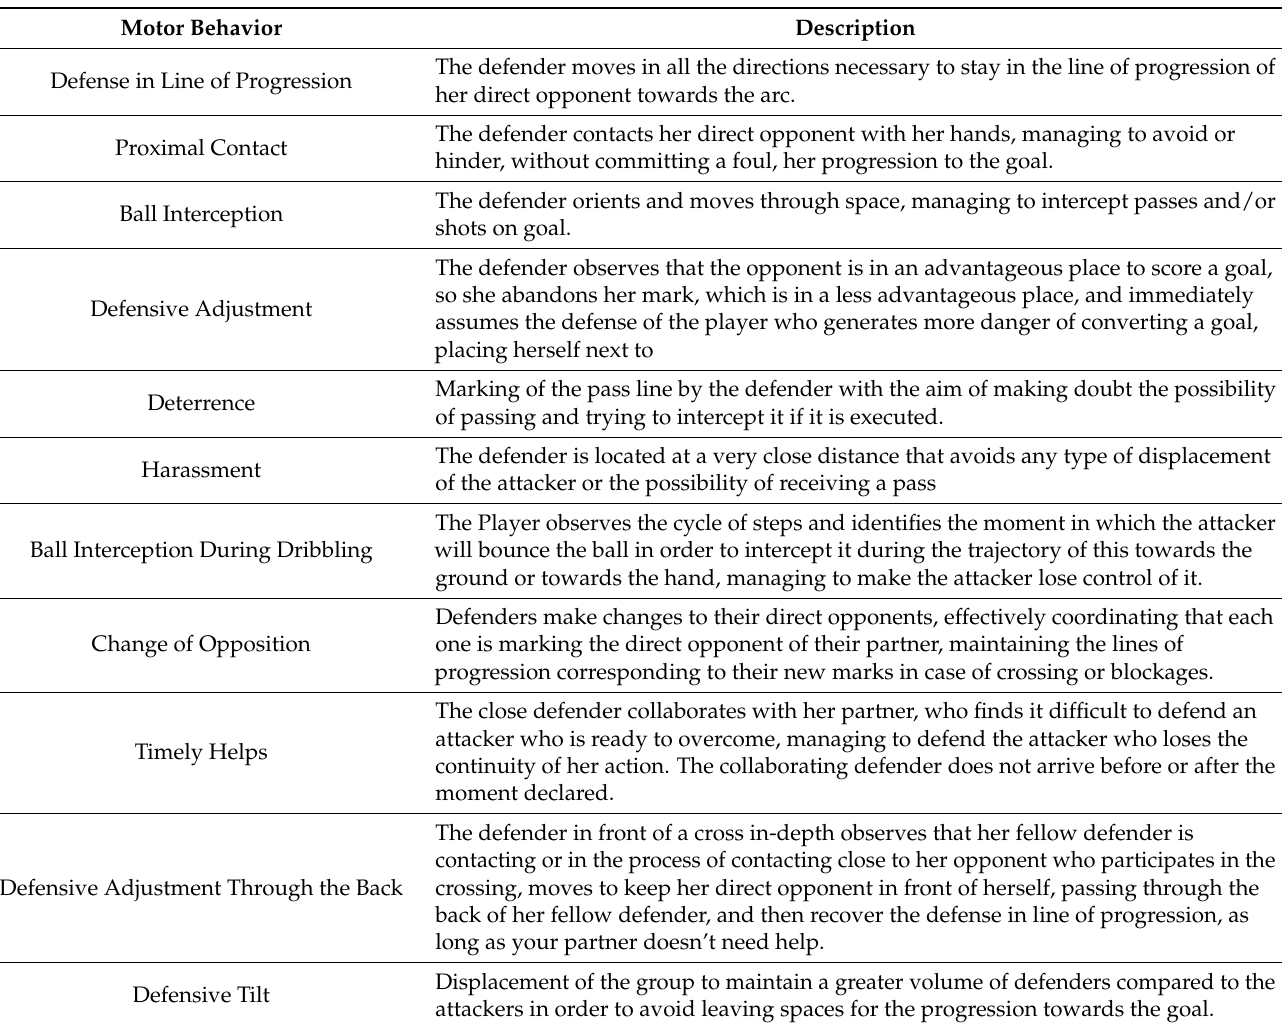
Table 1. Observational